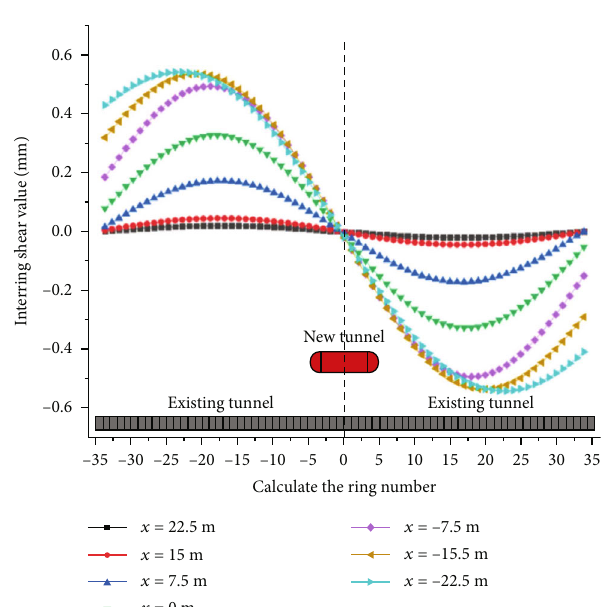
Figure 16: Variation curve of the amount of dislocation platform of existing shield tunnel